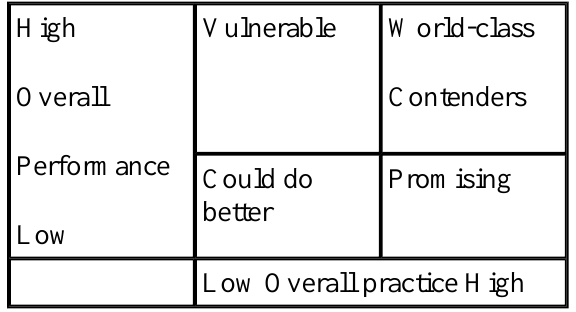
Table 1 Service performance and practice matrix (Voss et al.